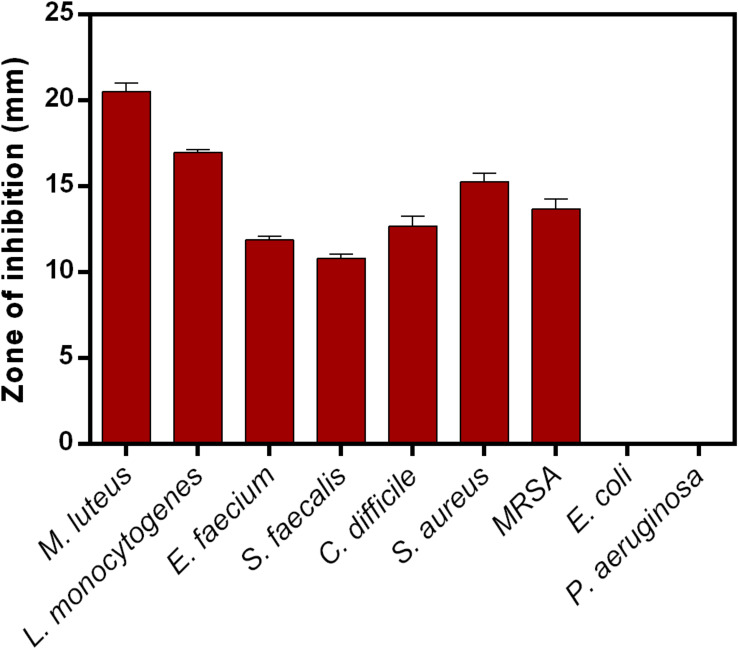
Antimicrobial activity of clausin lanthipeptide (5 mg) against indicator strains. Data points presented are the average of three independent experiments.